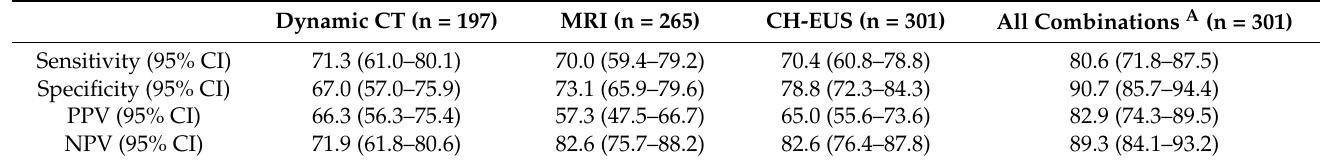
Table 2. Diagnostic performances of dynamic CT, MRI, CH-EUS, and all combinations (n = 301).